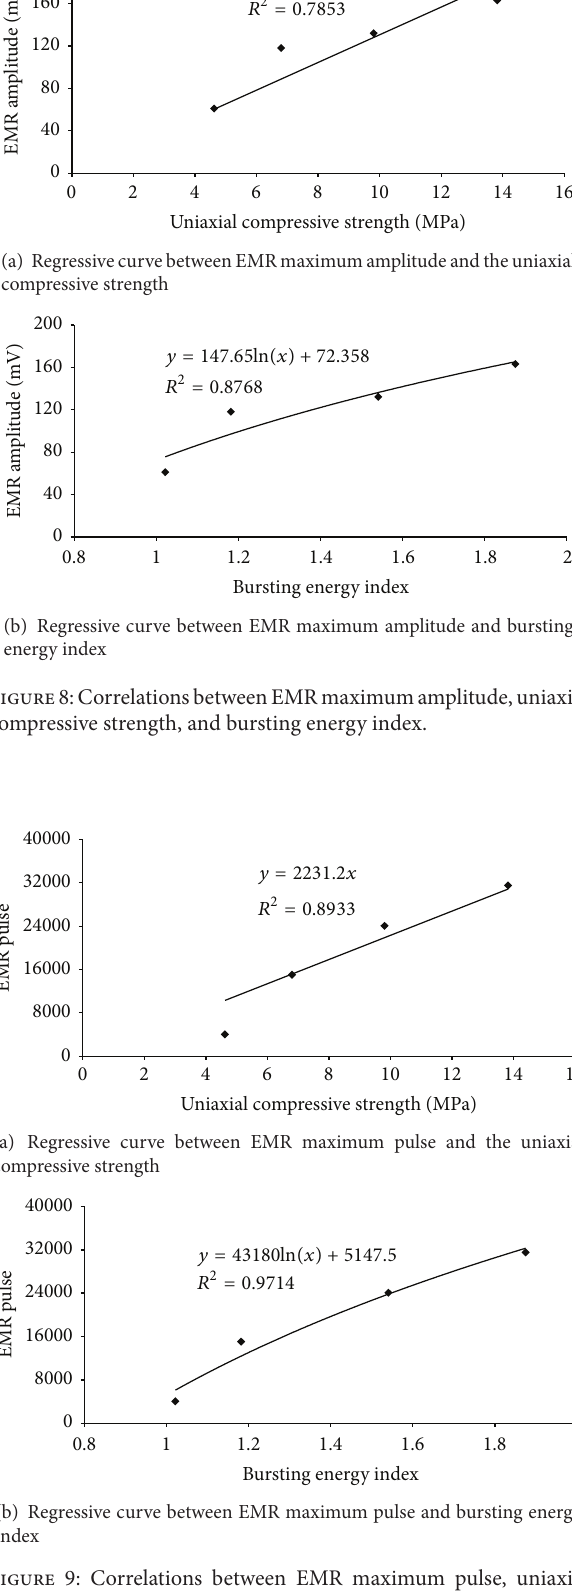
Figure 9: Correlations between EMR maximum pulse, uniaxial compressive strength, and bursting energy